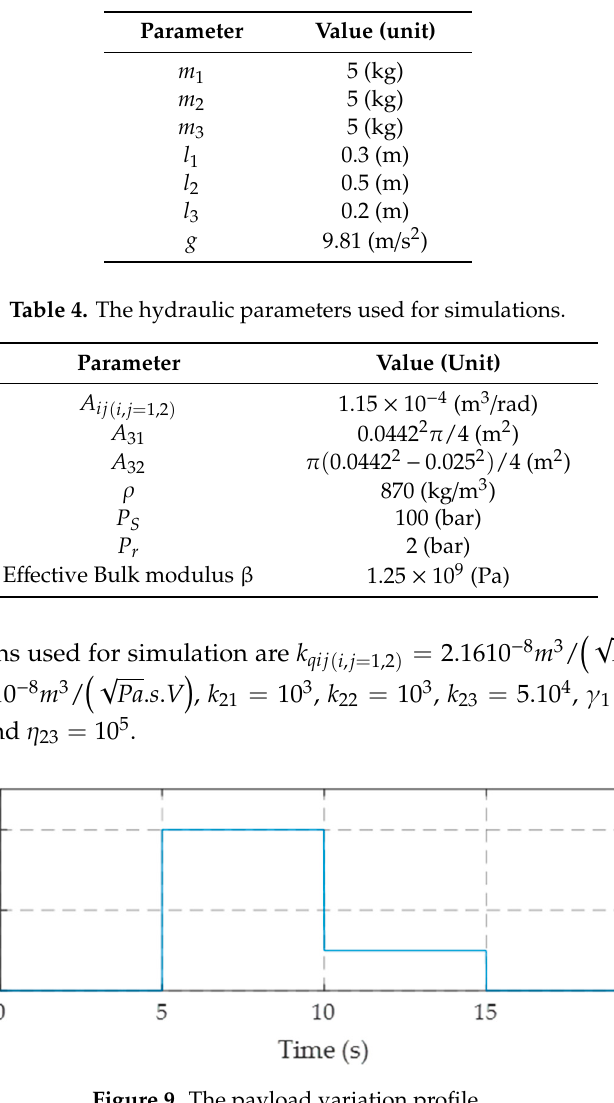
Figure 9. The payload variation profile.